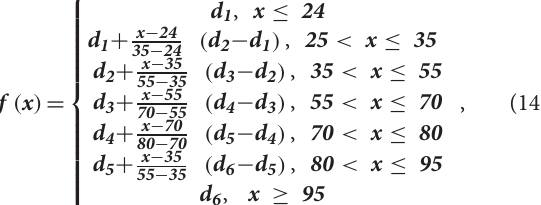
1). Then we can derive the age- = f ( x ) 2020,2021 for each year. Our e 2020,2021 =